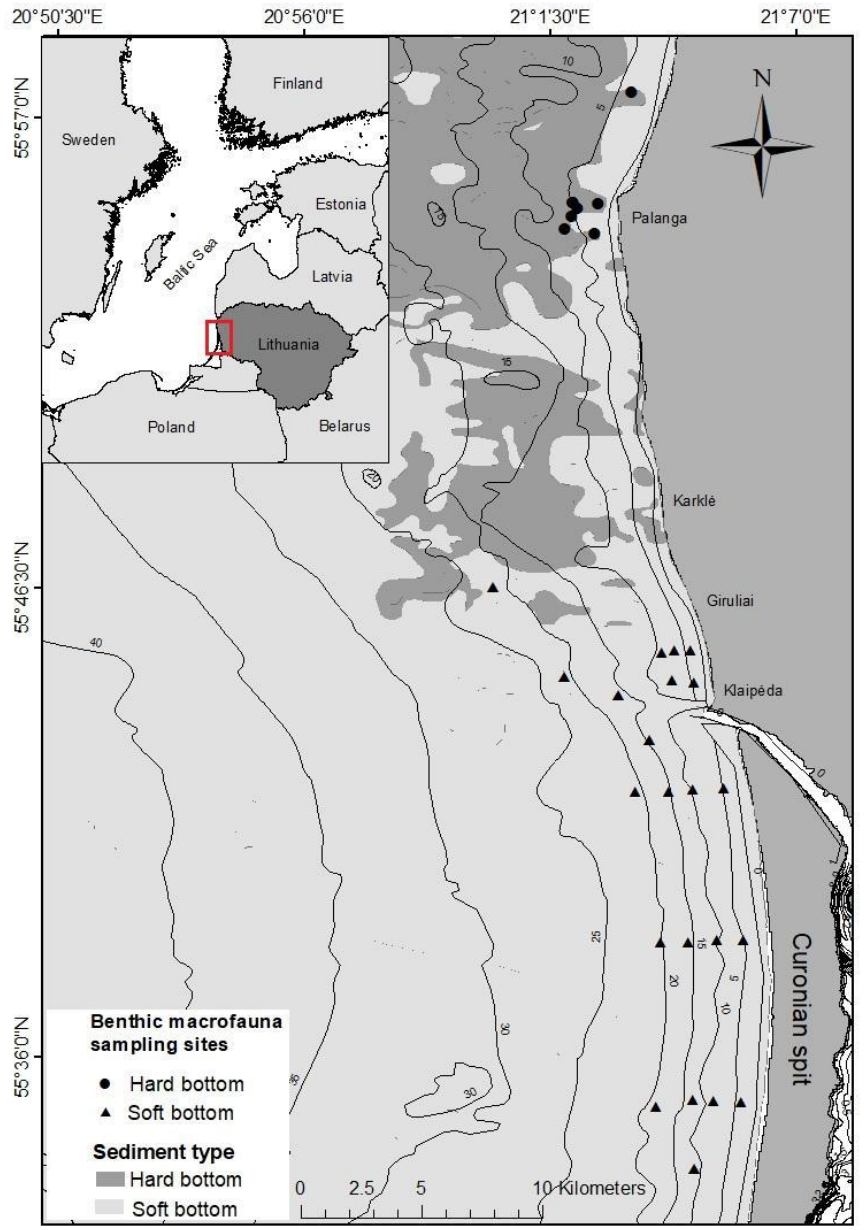
Figure 1. Distribution of hard- and soft-bottom habitats in the study area and locations of macrofauna sampling sites in two bottom types.